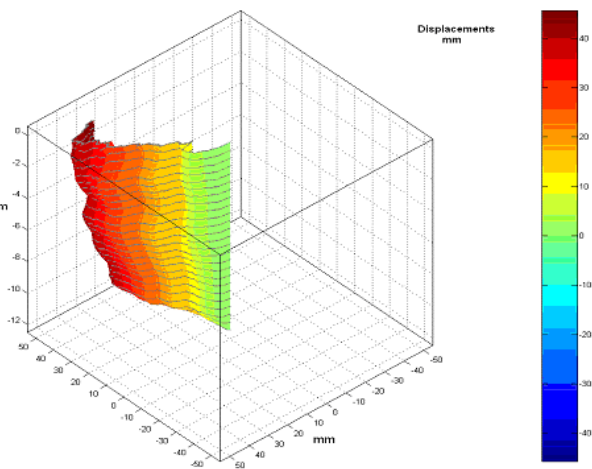
Figure 6. Ground displacement 3D model, Szymbark landslide.